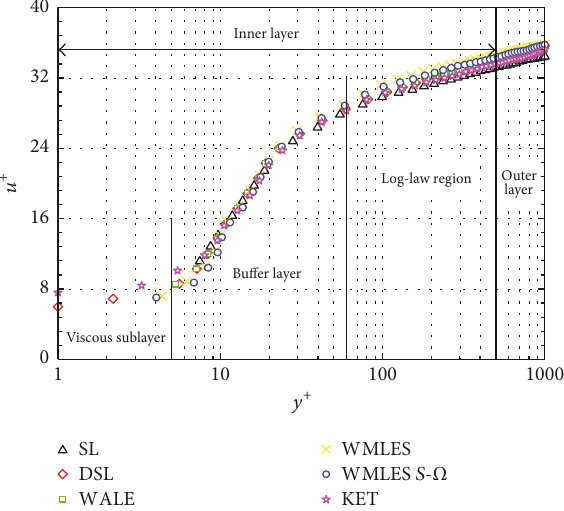
Figure 9: Boundary layer profiles near the pressure surface for